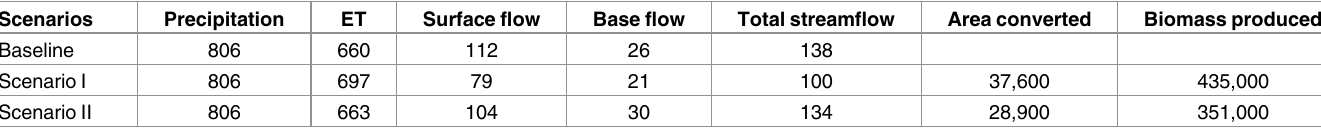
Table 4. Summaryof averageannual water balance (in mm) for the entire watershed during the simulation period (2002 through 2011) for the base- line simulation, scenario-I (grassland conversion to switchgrass), and scenario-II (marginal cropland conversion to switchgrass) along with the area converted (in ha) and switchgrass produced (in Mg) under each